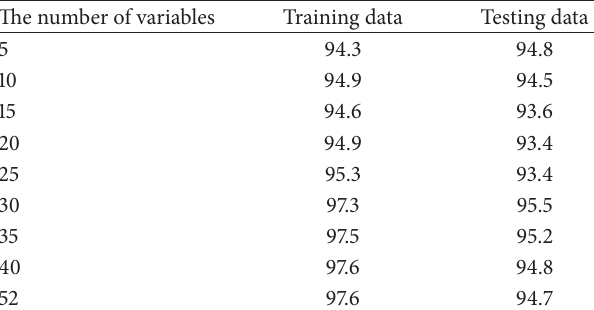
Table 2: TE process: fault detection rate for training and testing data by SVM-RFE.